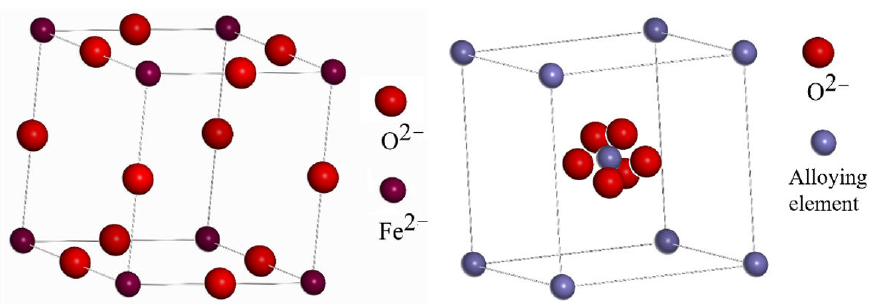
Figure 13. Schematic diagram of ion transmission at the interface between oxide layer and